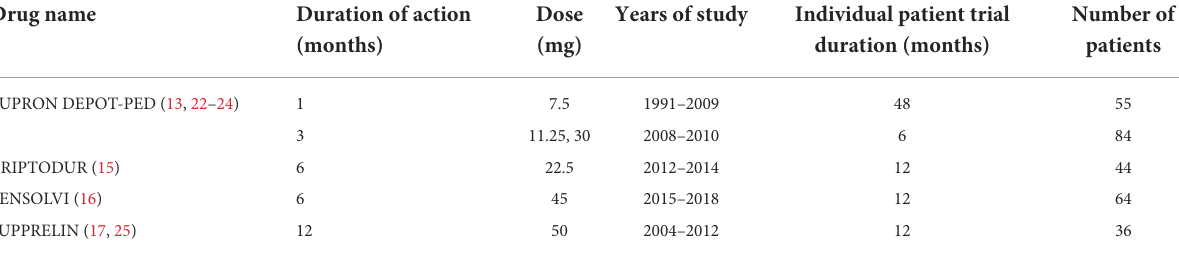
TABLE 1 Trial characteristics of CPP therapies (approved in US) in pivotal